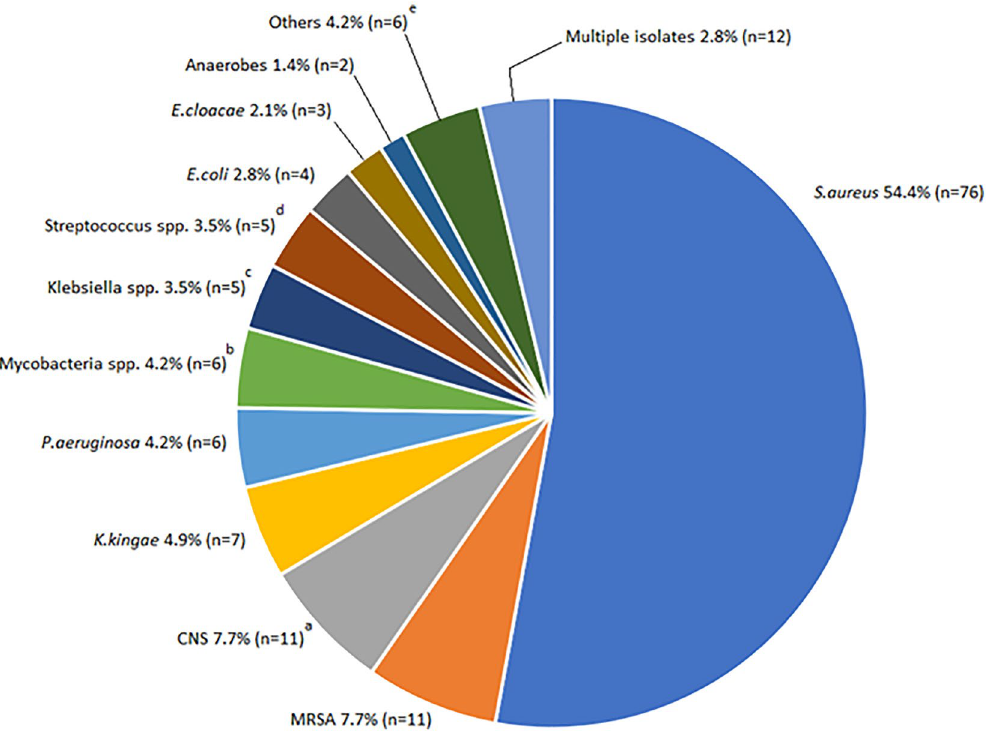
Figure 3. Infectious etiology of osteomyelitis in the study sample a S.epidermidis n = 2; S.hominis n = 4; S.intermedius n = 4; S.warneri n = 2 b M.tuberculosis n = 5; M.xenopi n = 1 c K.pneumoniae n = 4 (MDR n = 1); K.oxytoca n = 1 d S.mitis n = 1; S.oralis n = 1; S.pneumoniae n = 1; S.pyogenes n = 2. e A.baumanii n = 1; A.odontolyticyus n = 1; C.albicans n = 1; E.faecalis n = 1; P.mirabilis n = 1; Salmonella spp. n =